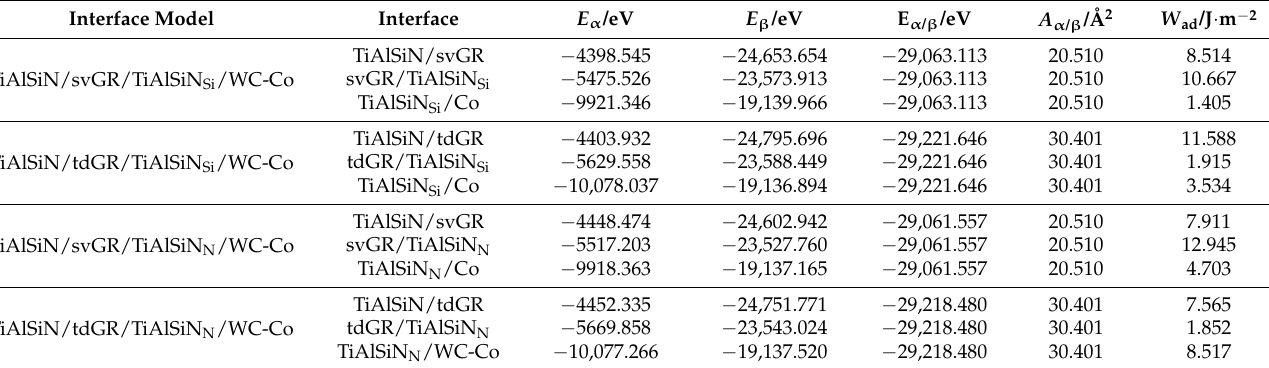
Table 5. Adhesion works of coating doped with defective graphene.